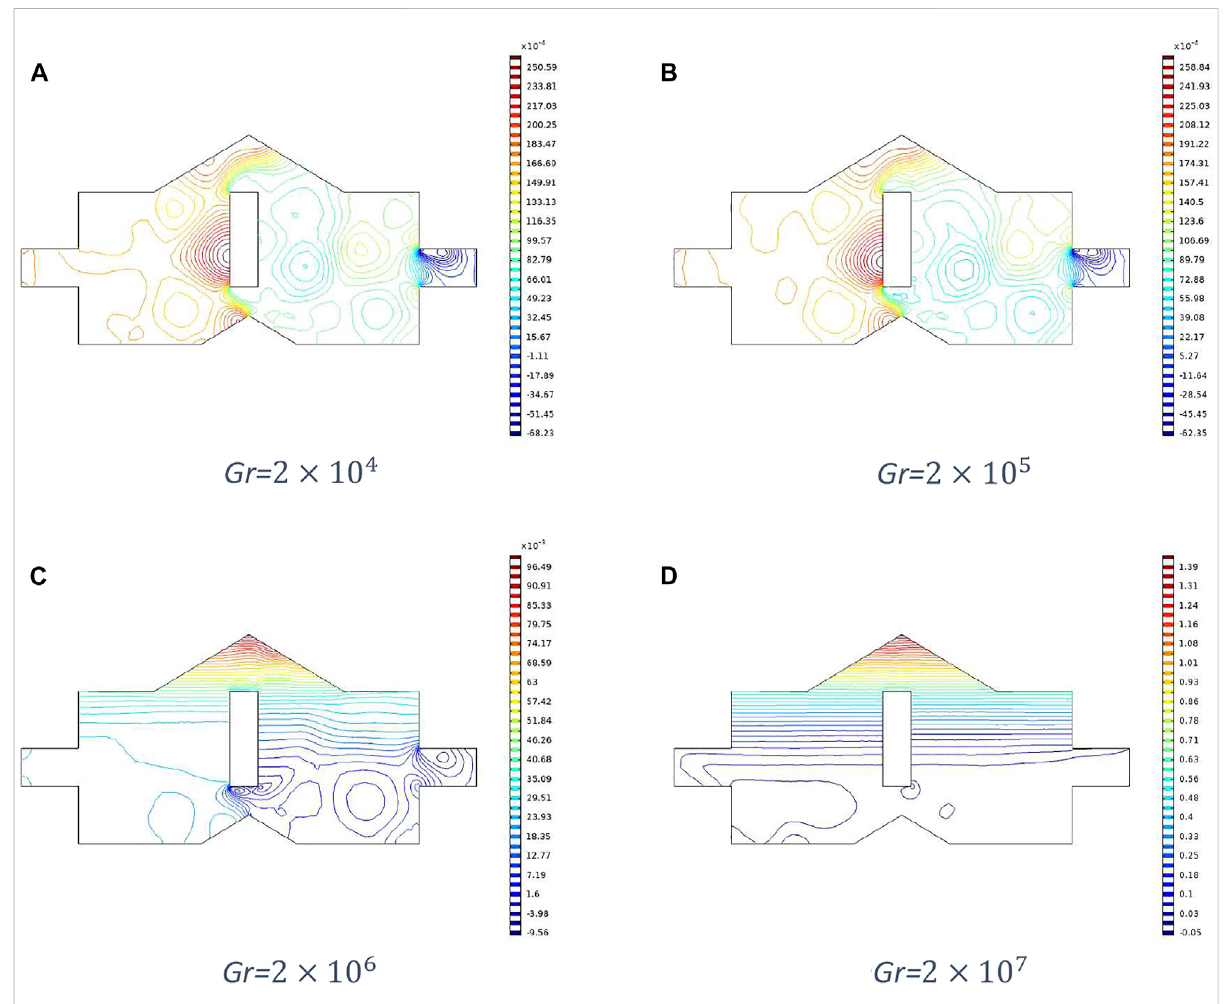
Pressure Variation at Re = 700 and at different Grashof